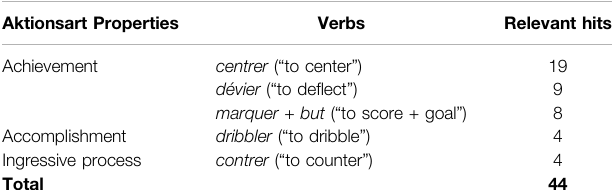
TABLE 3 | Aktionsart distribution of the French hits in Emolex.